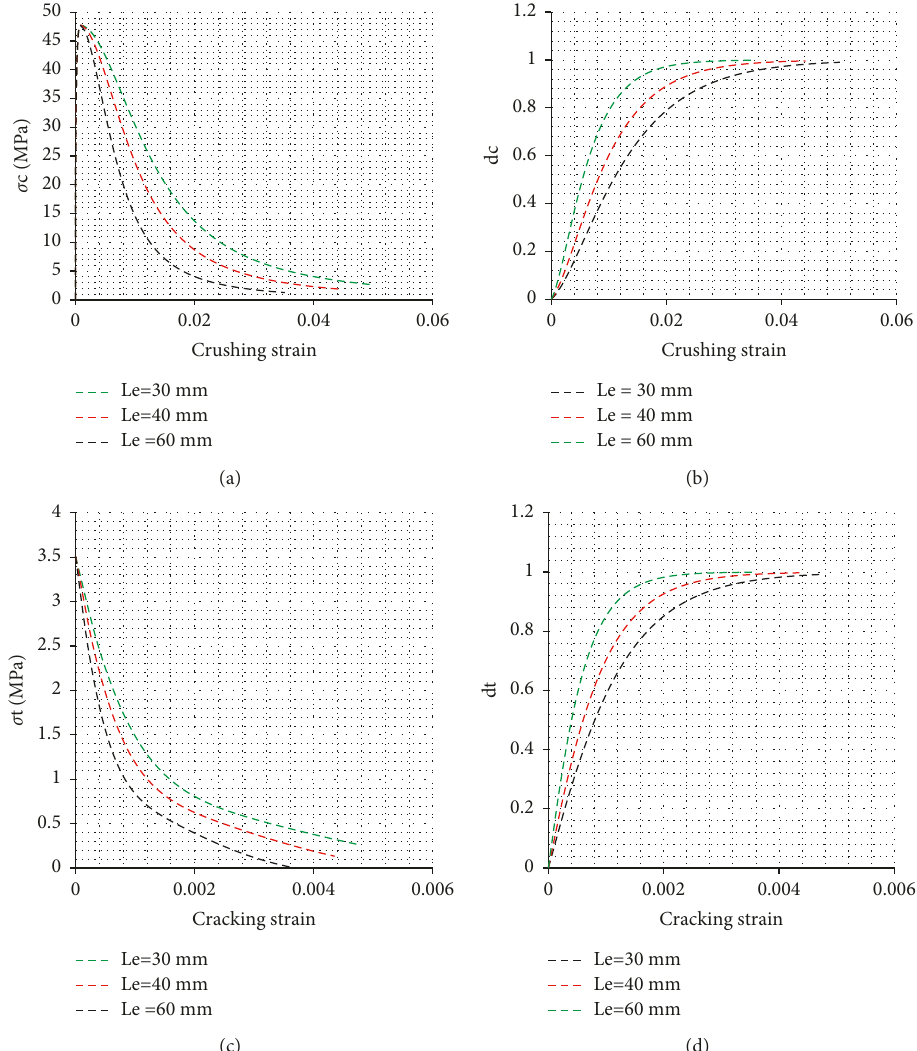
Figure 2: Concrete damaged plasticity model input based on different element sizes for concrete grade with 47.7MPa. (a) Compressive stress vs crushing strain. (b) Compressive damage vs crushing strain. (c) Tensile stress vs cracking strain. (d) Tensile damage vs cracking